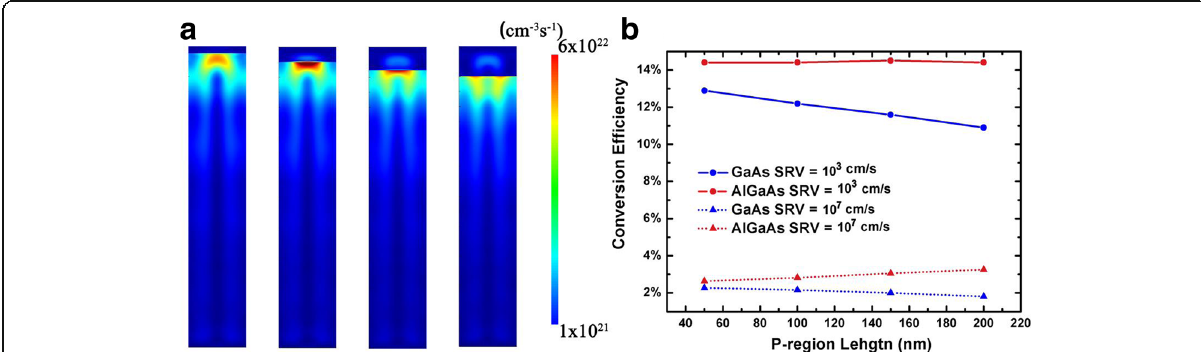
Fig. 4 a The vertical cross section of optical generation profiles in AlGaAs/GaAs nanowire axial pin heterojunction solar cells with different p -region lengths. b The conversion efficiency of GaAs and AlGaAs/GaAs nanowire axial solar cells as functions of p-region length